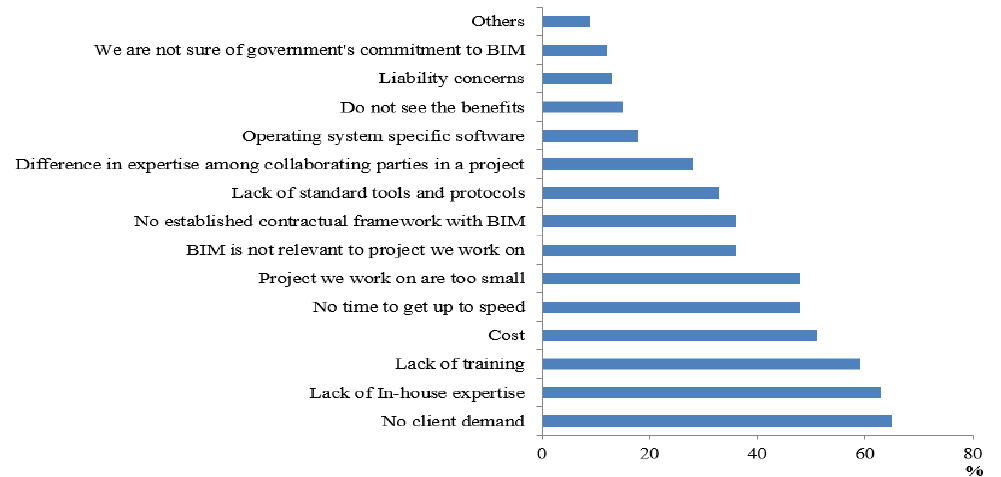
Fig. 5. Hindrances or barriers to the adoption of BIM in the UK (National BIM Report, 2019, p. 22).